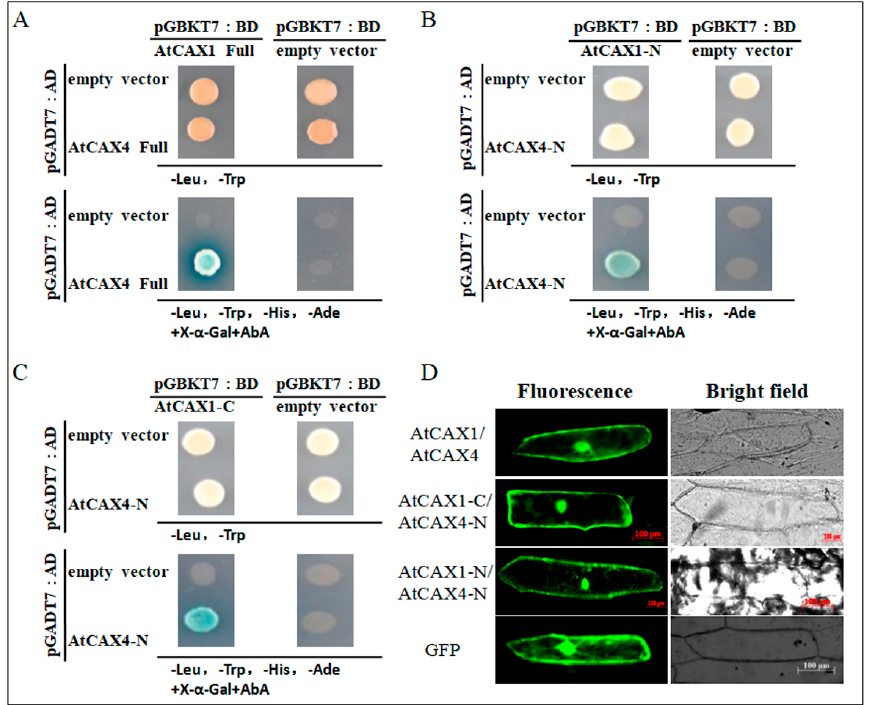
Figure 1. AtCAX1 interacts with AtCAX4. ( A – C ) Yeast two-hybrid assay. The combinations of plasmids: full length of pGBKT7-AtCAX1 and pGADT7-AtCAX4 ( A ), C-terminus of pGBKT7- AtCAX1 and N-terminus sequence of pGADT7-AtCAX4 ( B ), N-terminus of pGBKT7-AtCAX1 and N-terminus sequences of pGADT7-AtCAX4 ( C ) were co-transformed into yeast Y2HGold cells. Transformed yeast cells were grown on SD-Leu-Trp and SD-Leu-Trp-His-Ade+X-a-gal+AbA medium for 2–3 days at 30 °C. ( D ) Bimolecular fluorescence complementation (BiFC) in onion epidermal cells. The combinations of plasmids (full length of AtCAX1-nGFP and AtCAX4-cGFP, C-terminus of AtCAX1 and N-terminus of AtCAX4, N-terminus of AtCAX1 and N-terminus of AtCAX4) are shown on the left. GFP was used a control. Scale bar = 100 μ m.